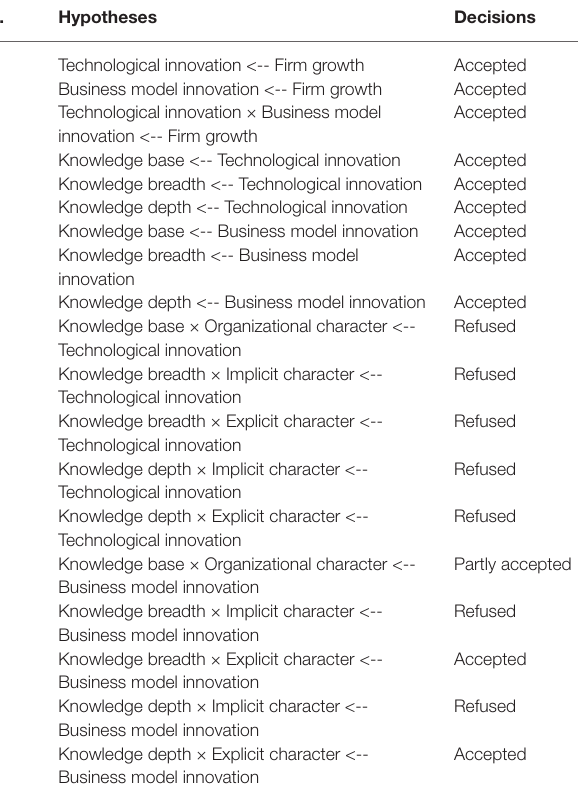
TABLE 7 | Summary of the results. TABLE 6 | Binary logistic regression analysis of business model innovation.